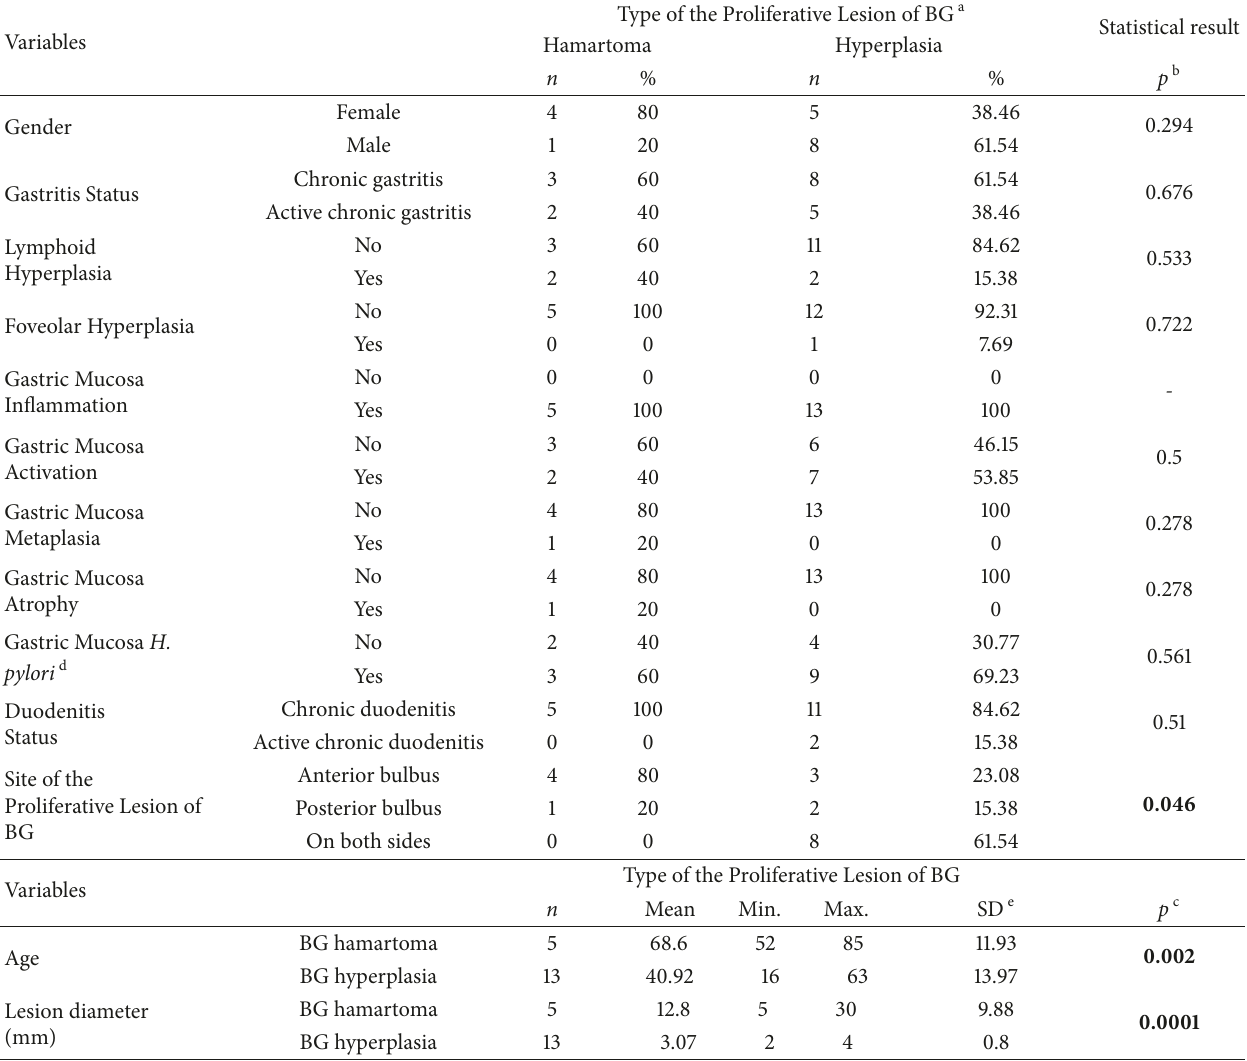
Table 2: Association between the proliferative lesions of Brunner’s gland and the